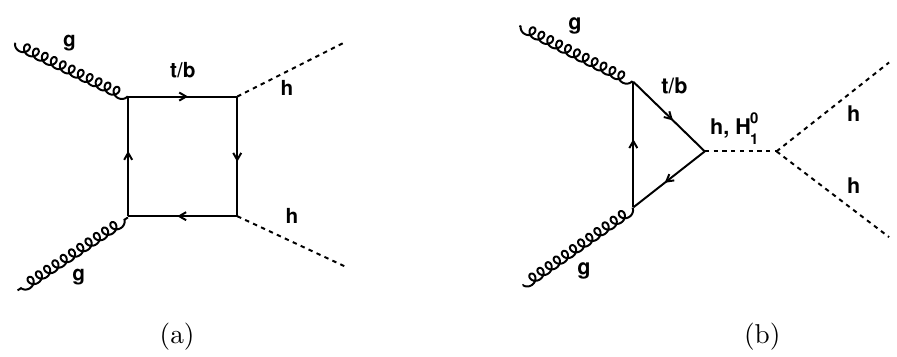
Figure 1 . Feynman diagrams for Higgs bosons pair production in the GM